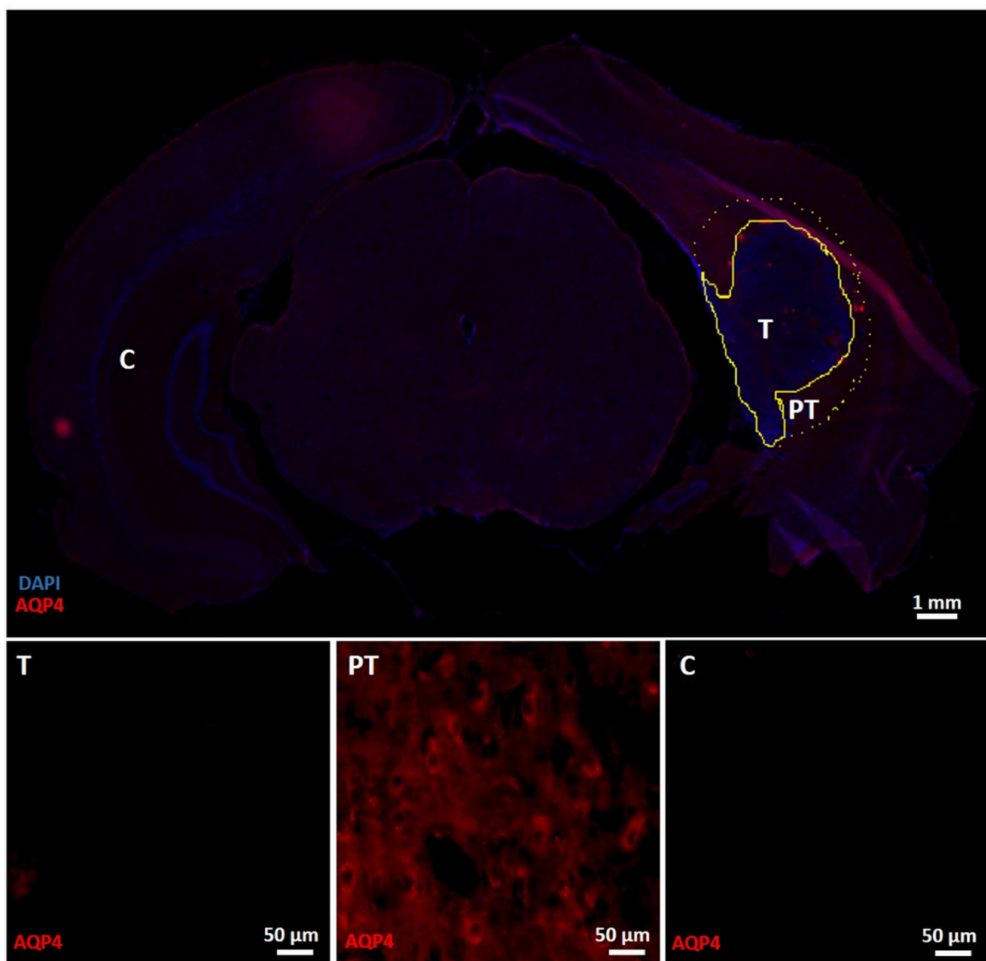
Figure 6. Immunohistochemical analysis for AQP4. The upper panel shows an overview slice with AQP4 and DAPI expression. The tumor mass (T) is delineated by a yellow line. Around the tumor mass, a peritumoral area (PT) was delineated by a yellow dashed line. The lower panel shows ROIs in the different zones. T: ROI in the tumor mass with AQP4 staining; AQP4 staining intensity is increased in tumor mass compared to the contralateral healthy brain tissue (C). PT: ROI in the peritumoral region with AQP4 staining; a significant increase in AQP4 staining intensity is observed in the peritumoral regions. C: ROI in the contralateral healthy brain tissue with AQP4 staining; AQP4 staining intensity is low. T—tumor mass; PT—peritumoral region; C—contralateral healthy brain